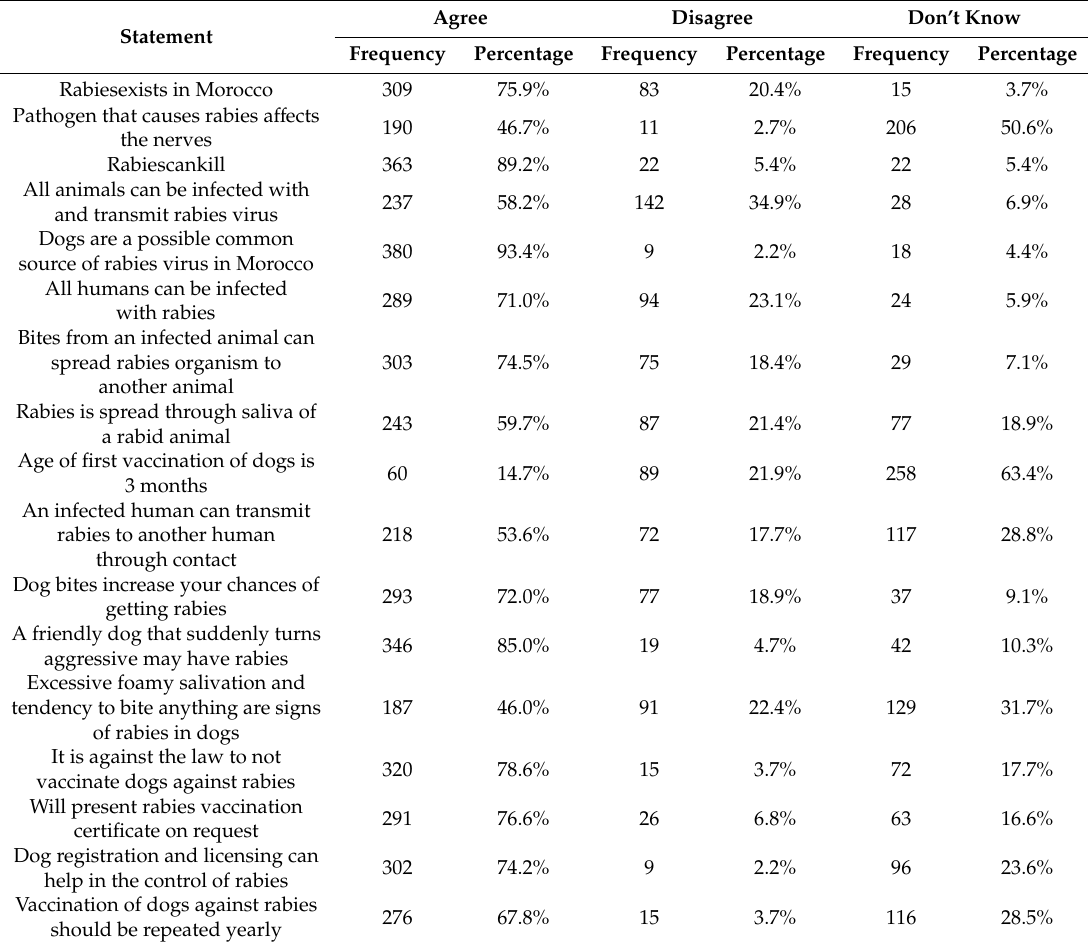
Table 2. Knowledge of rabies by study